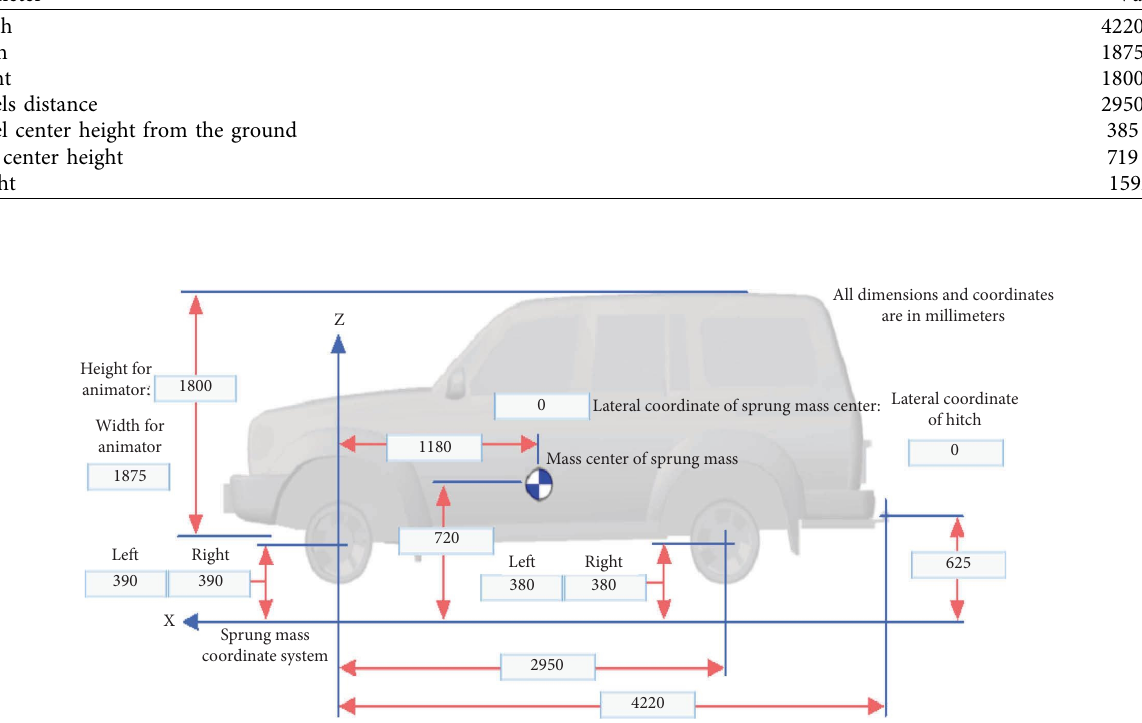
Figure 5: Dimensions and mass of E-class